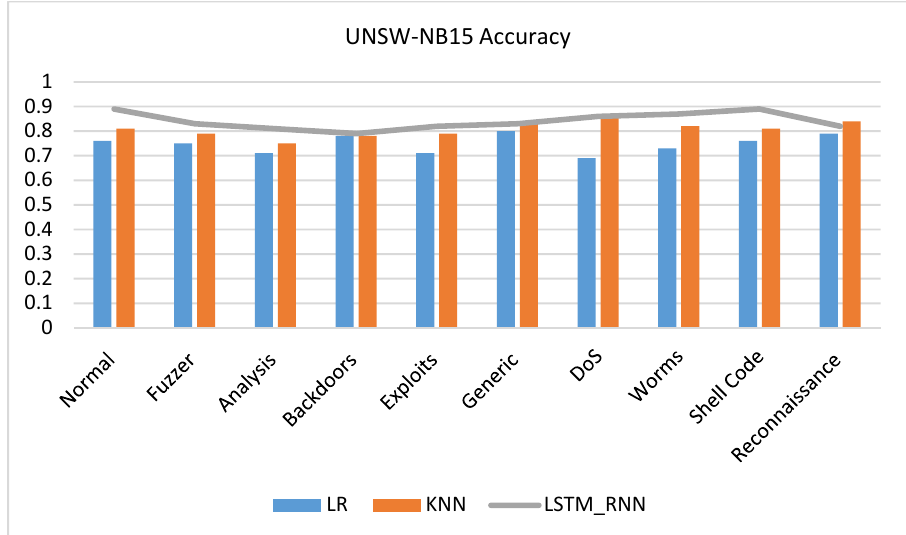
Figure 14. UNSW-NB15 Multiclass classification details accuracy comparison.